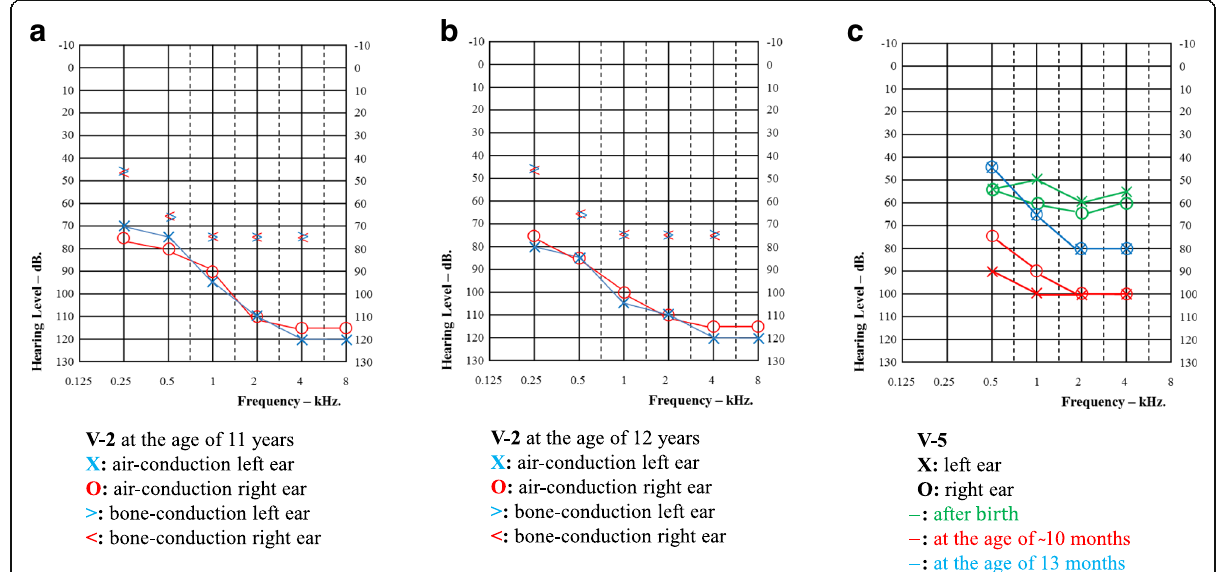
Fig. 2 Auditory evaluations of V-2 and V-5. Circles and crosses denote thresholds for the left and right ear, respectively. a Pure-tone audiograms of V-2 at the age of 11 and b 12 years. Air-conduction thresholds for right and left ears are represented with circles and crosses, respectively. Bone-conduction is represented > and < for left and right ears, respectively. c ASSR measurements for V-5. ASSRs were measured at three different time points: first after birth (green), at the age of 10 months (red) and at the age of 13 months